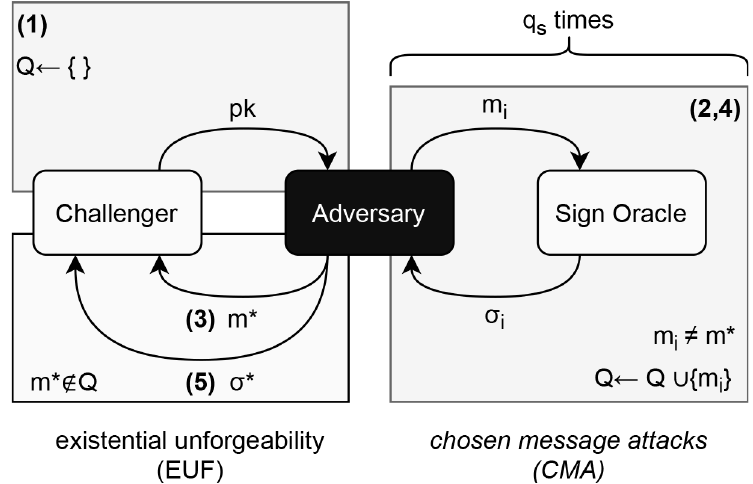
Figure 3. EUF-CMA security